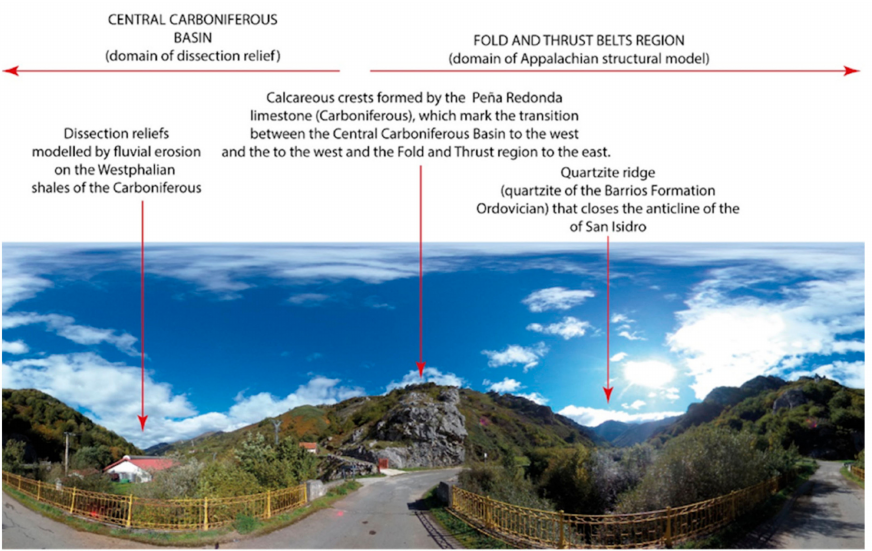
Figure 8. 360 ◦ photograph from the first POI. Photograph by the authors. Focus with camera on Figure through Onirix site or use the link